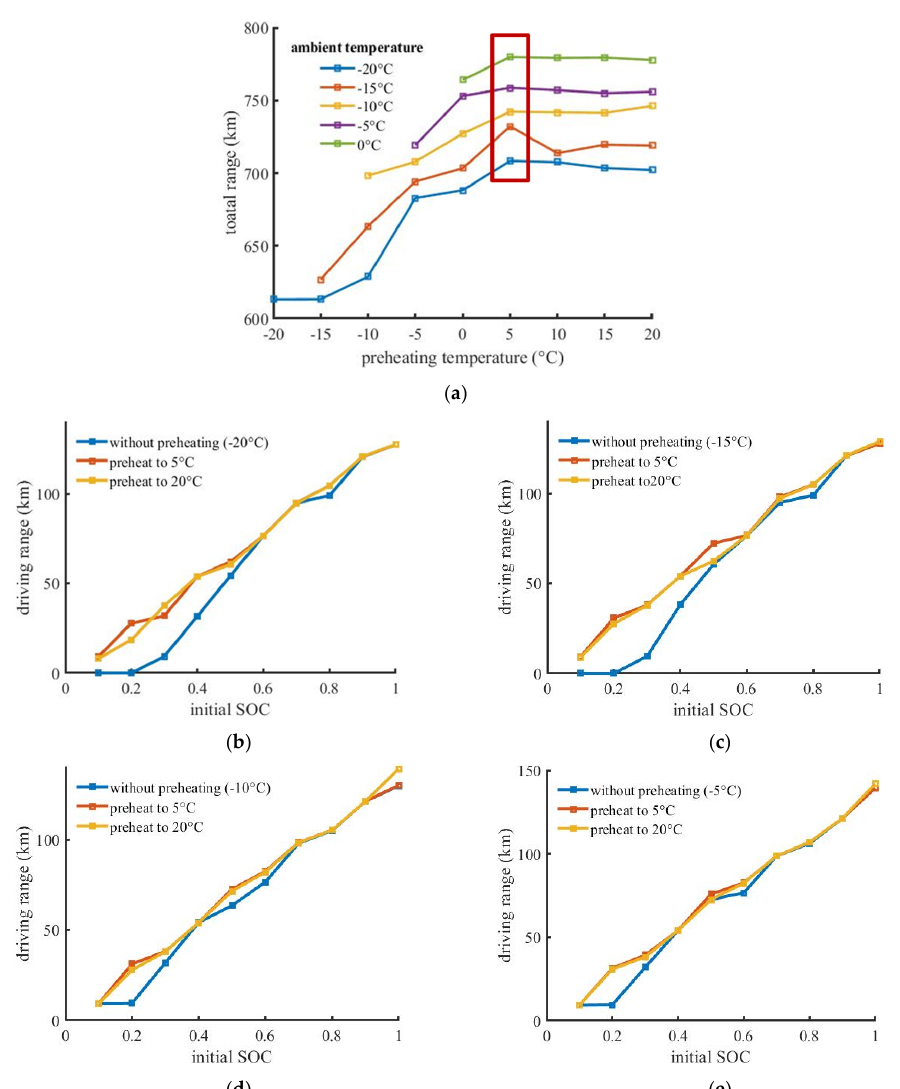
Figure 9. Simulation results in different ambient temperatures under the WLTC driving condition: ( a ) total driving range; ( b ) detailed results of the ambient temperature of − 20 °C; ( c ) detailed results of the ambient temperature of − 15 °C; ( d ) detailed results of the ambient temperature of − 10 °C; and ( e ) detailed results of the ambient temperature of − 5 °C.